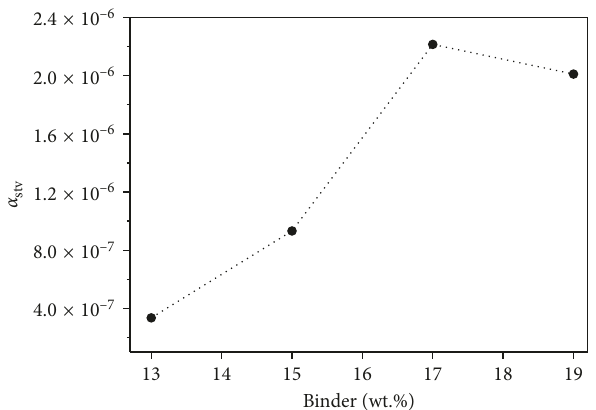
Figure 7: General moldability index versus binder content